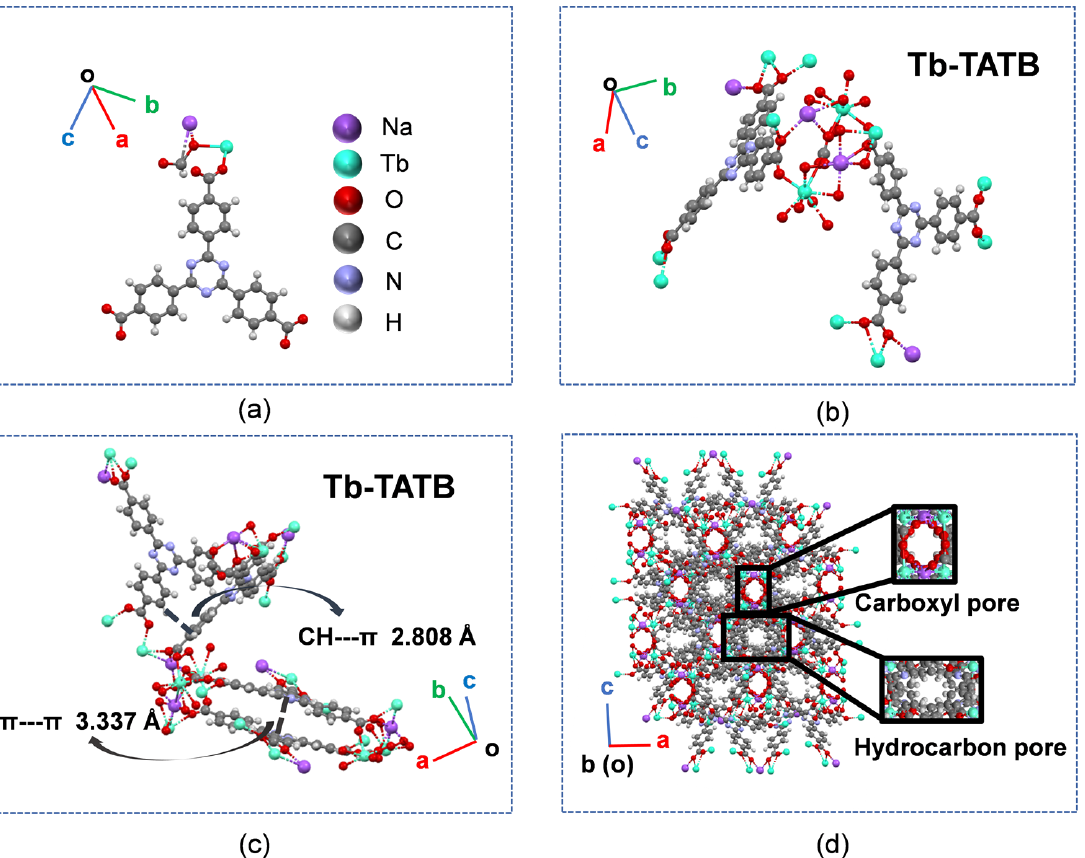
Figure 5. ( a ) Minimum asymmetric element structure of Tb-TATB. Deep purple = Na; lake blue = Tb; red = oxygen; gray = carbon; light purple = nitrogen; and white = hydrogen. ( b ) Schematic diagram of Tb 3+ coordination environment. ( c ) Tb-TATB crystals. CH- π , π - π short-contacts were shown in these stacked molecular conformations. ( d ) Three-dimensional framework structure diagram of square crystal from the 001